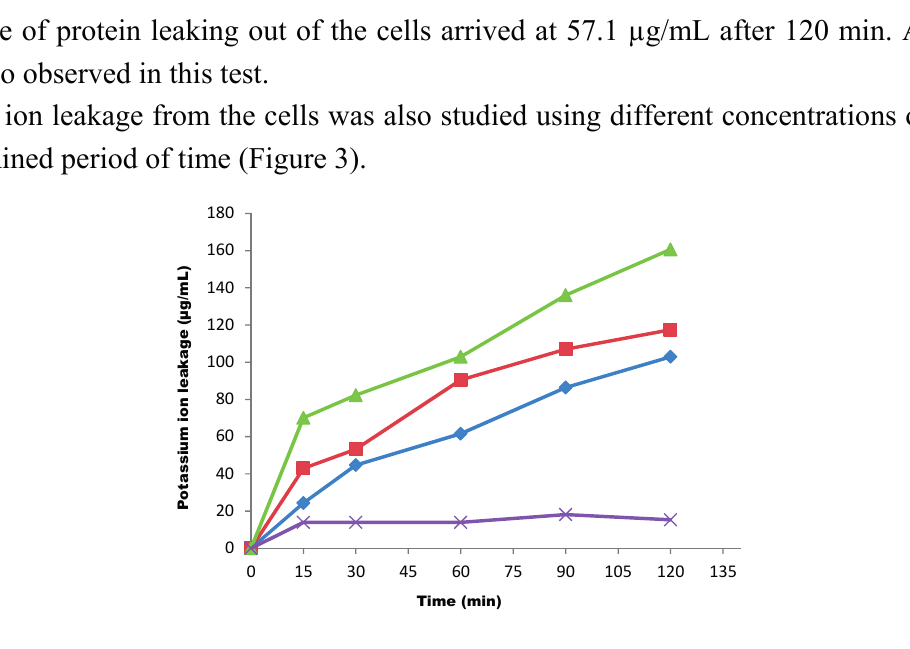
Figure 3. The effect of the butanol fraction on potassium ion leakage from test cells at concentrations of 1× MIC ( ◊ ), 2× MIC ( ■ ), 3× MIC ( ▲ ) and control (X). Each point represents the amount of potassium ions leaked (µg/mL) from the cells at a particular time interval in the presence of the